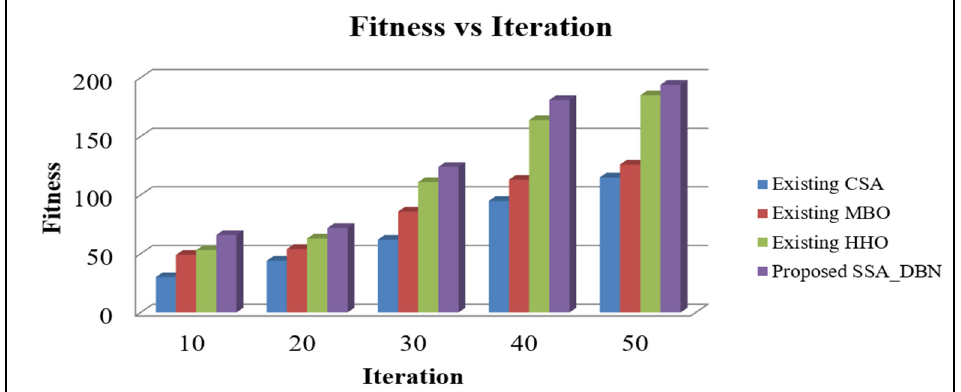
Figure 8. Fitness vs. iteration for proposed parallel SSA-DBN.